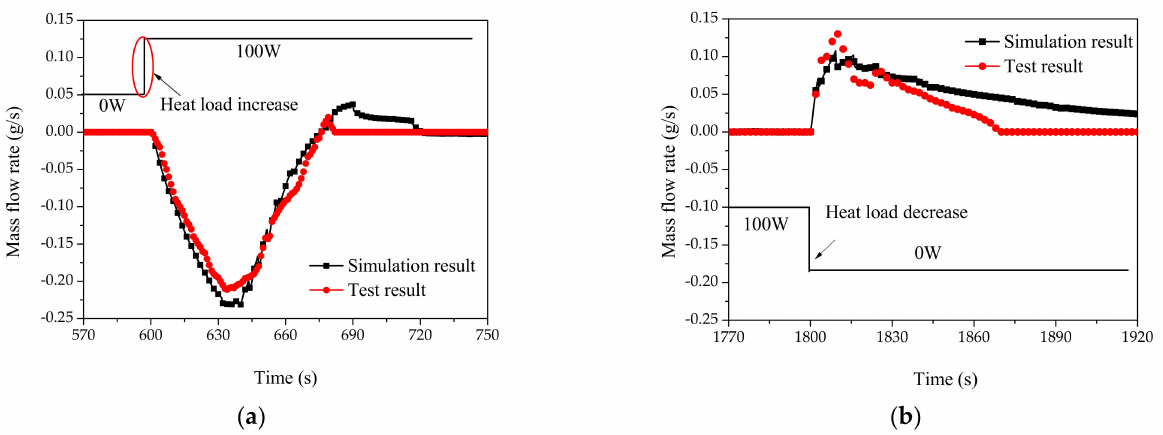
Figure 4. Mass flow ( a ) into and ( b ) out of the accumulator resulting from an increase and decrease of heat input,